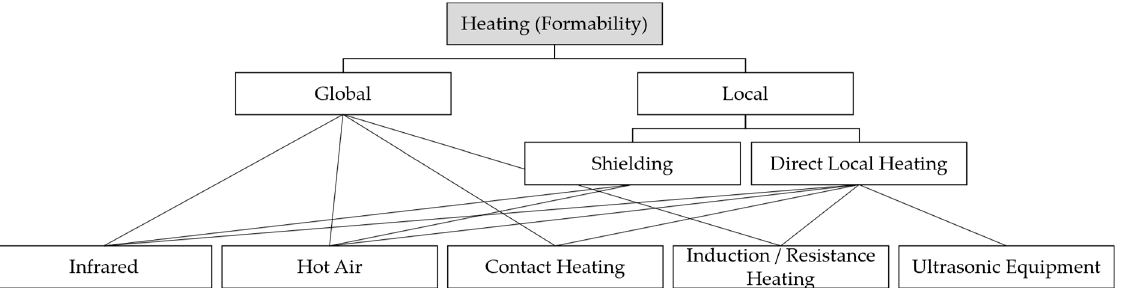
Figure 6. Possible process alternatives for heating of thermoplastic polymers for acquiring formability of the matrix.